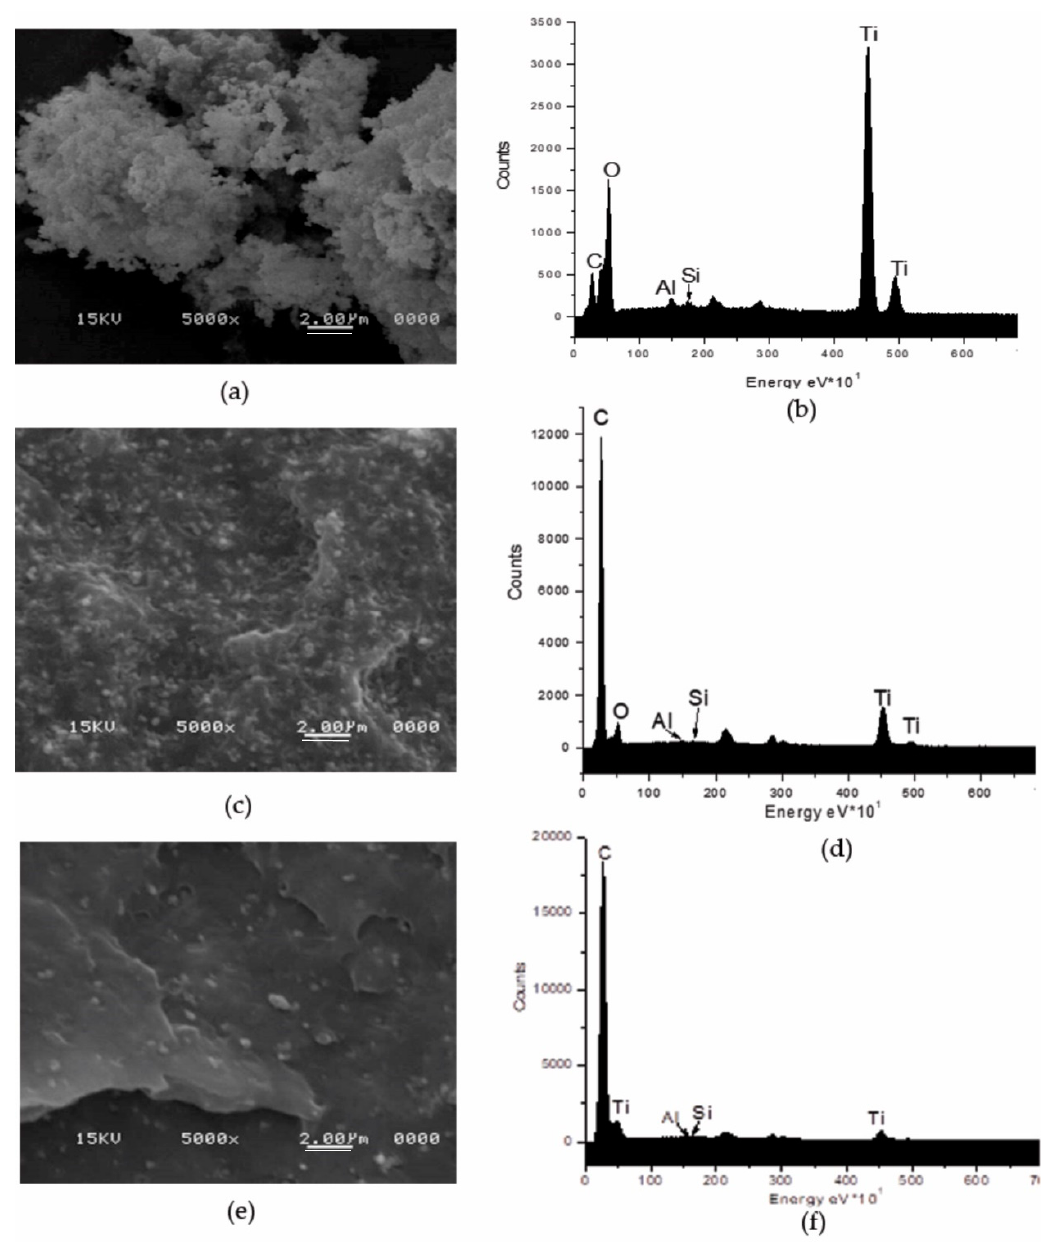
Figure 1. SEM images at 5000 × of the TiO 2 particles, its dispersion and EDS spectra. ( a , b ) As-received TiO 2 powder; ( c , d ) dispersed in PE by extrusion (MB30.PE2); ( e , f ) dispersed in PE by USME-VF (MB30.PE2. USME-VF).